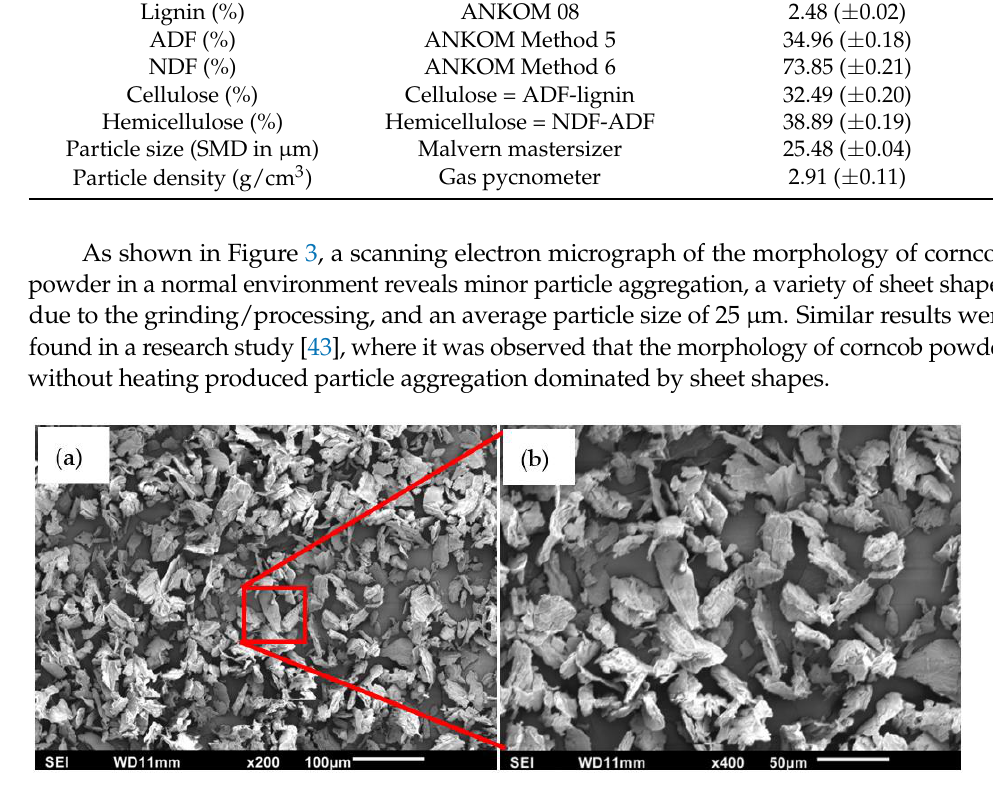
Figure 3. Scanning electron micrograph showing particle morphology of corncob powder (20 µm sieve): ( a ) At low magnification; and ( b ) At higher magnification.